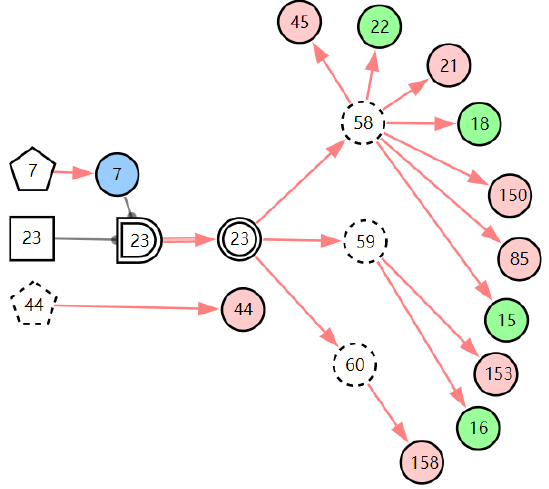
Figure 11. The graphic interpretation of LPR when E ’ = X 7,4 X 52,1 X 85,1 X 21,1 X 15,1 X 45,1 X 44,1 X 150,1 X 5,1 X 153,1 X 158,1 . X 5,1 X 153,1 X 158,1